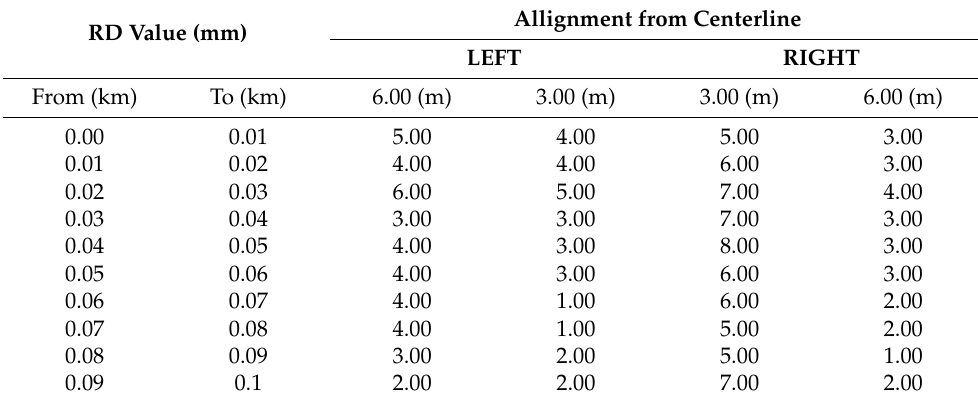
Table 4. An exemplary extraction of rutting depths values registered for the case study.